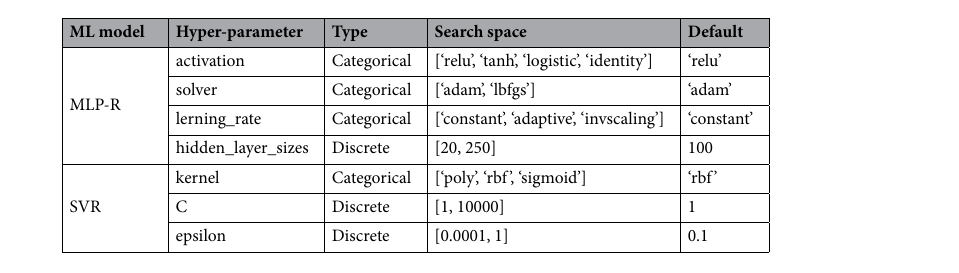
Table 2. Specifics of the configuration space for the